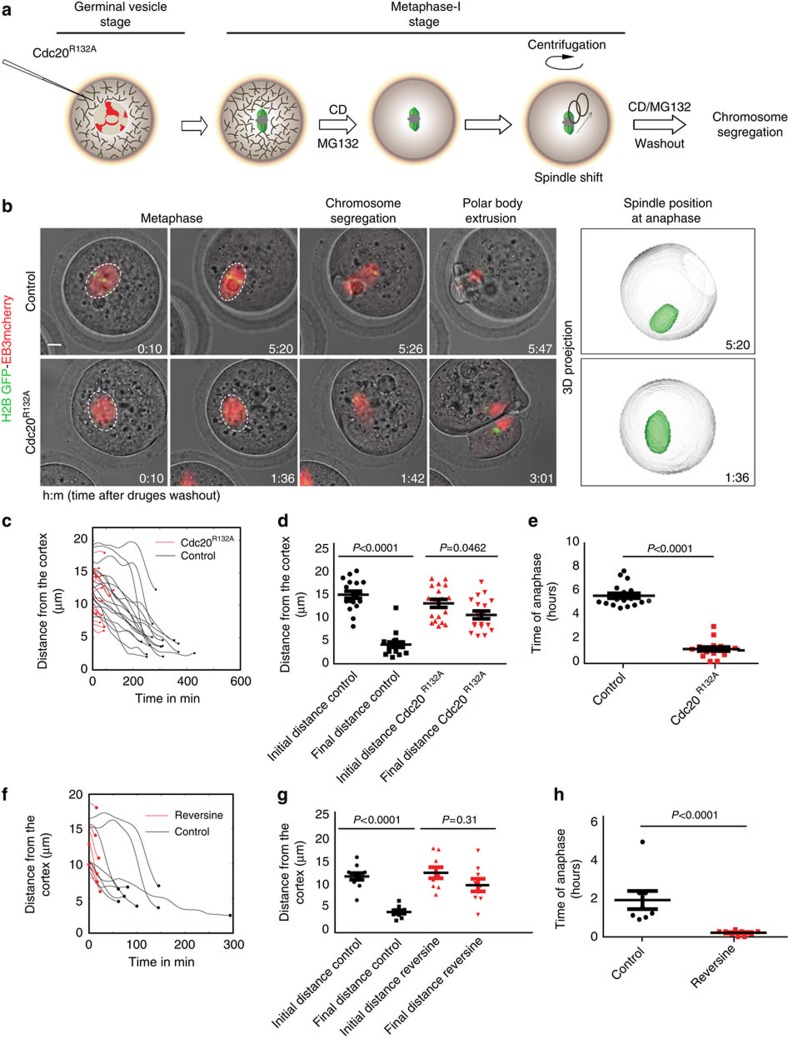
SAC depletion inhibits SPC.(a) Protocol of SAC inhibition by Cdc20R132A microinjection combined with the SPC assay. (b) Time-lapse imaging of Cdc20R132A-injected and control oocytes expressing EB3-mCherry (microtubule) and H2B-EGFP (chromosome) after CD/MG132 washout. Three-dimensional projection of the oocyte (white) and spindle (green) with Amira software from oocytes at the onset of anaphase. (c) Quantitative analysis of the spindle displacement, (d) initial (at the drug washout) and final distances (at anaphase onset) from the cortex (P<0.0001 in control oocytes, P=0.0462 in Cdc20R132A-injected oocytes) and (e) time of anaphase after the drugs washout in control (n=15, in black) and Cdc20R132A-injected oocytes (three independent experiments, n=18, in red, P<0.0001). (f) Dynamic of spindle relocation, (g) initial and final distance from the cortex (P<0.0001 in control oocytes and P=0.31 in Reversine-treated oocytes) and (h) time of anaphase after the drugs washout (two independent experiments, n=8, in black) in control and in reversine-treated oocytes (two independent experiments, n=8, in red; P<0.0001). Scale bar, 10 μm. Data are mean, with error bars displaying s.d. P-values were calculated with Student's test (nonparametric test, two tailed).